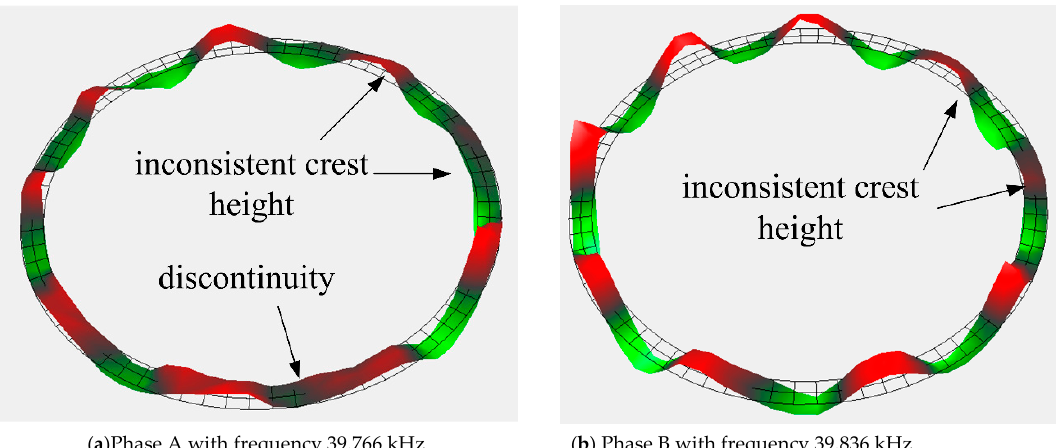
Figure 11. Vibration characteristic of stator 1